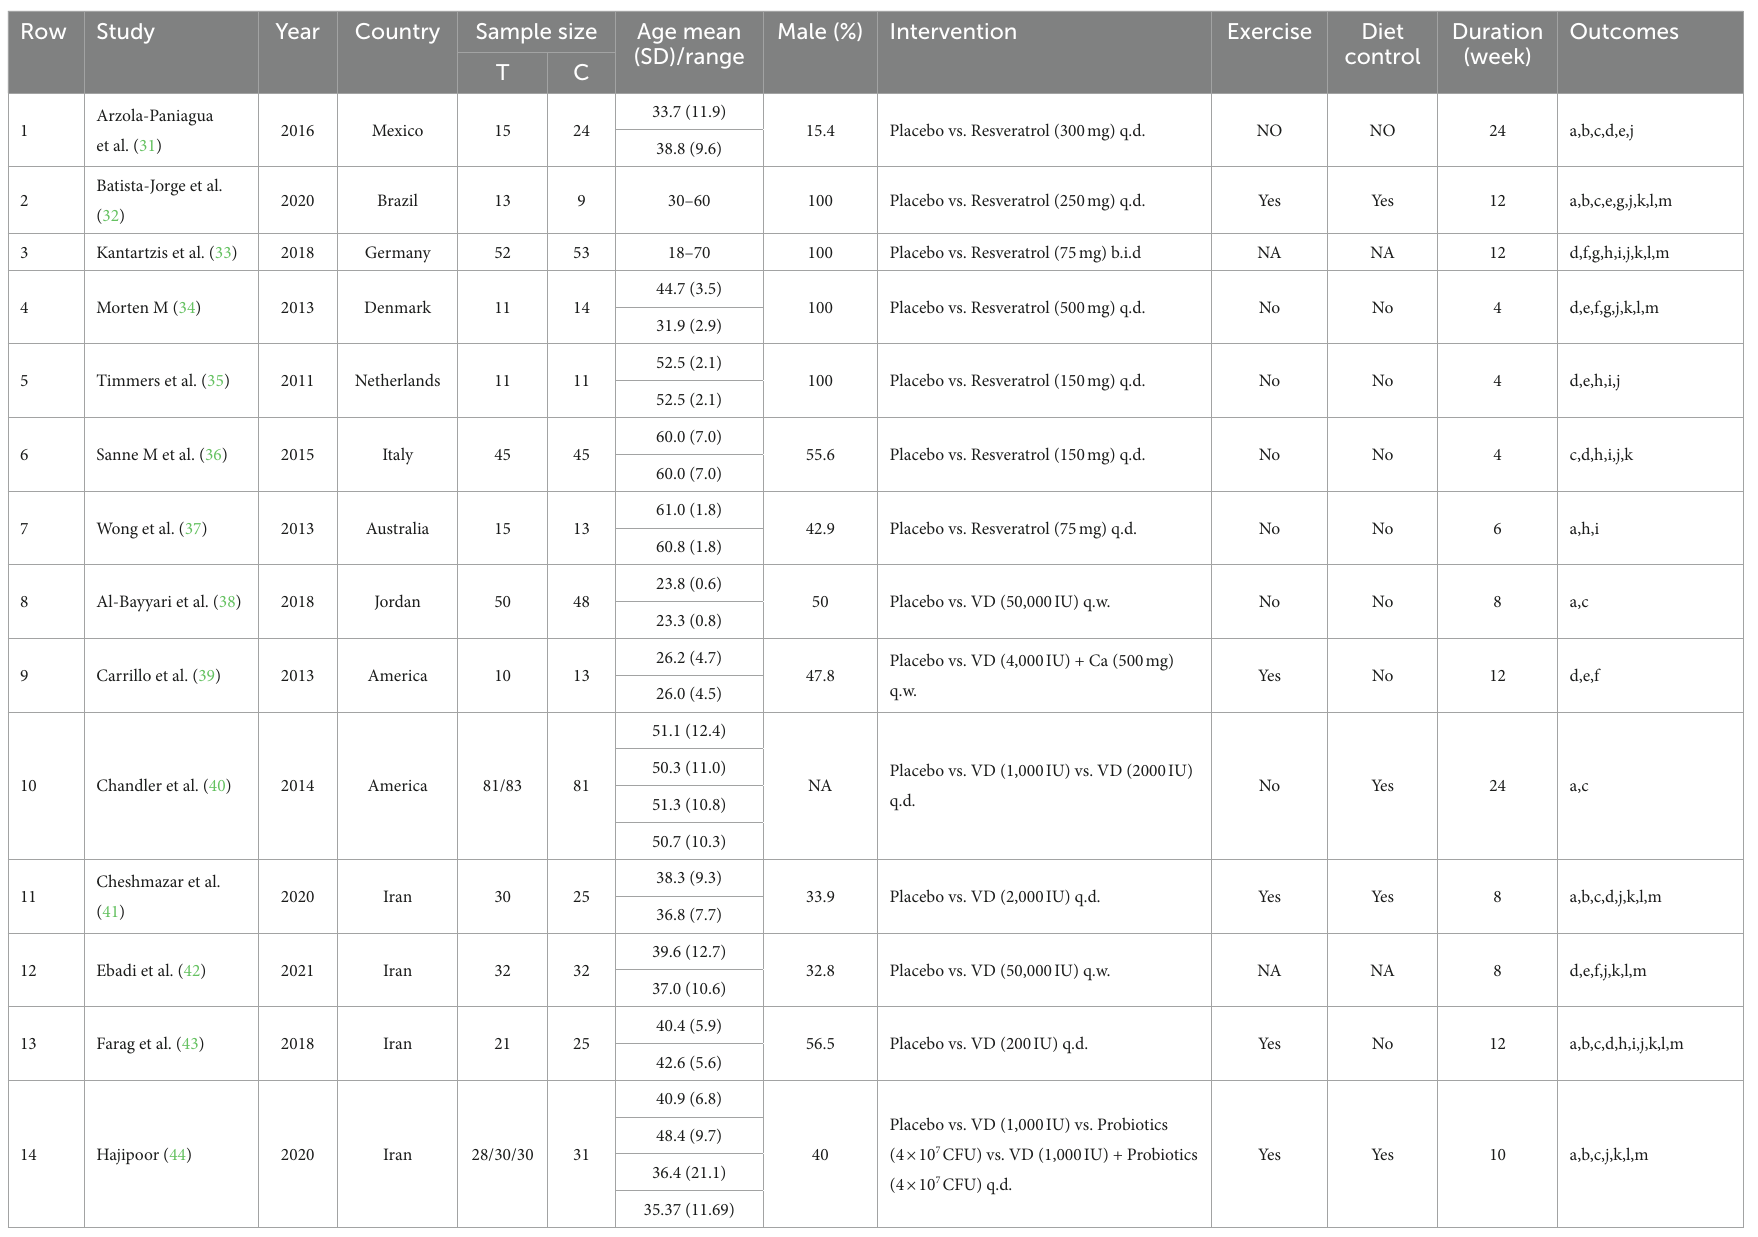
TABLE 1 Characteristics of studies included in the network meta-analysis.